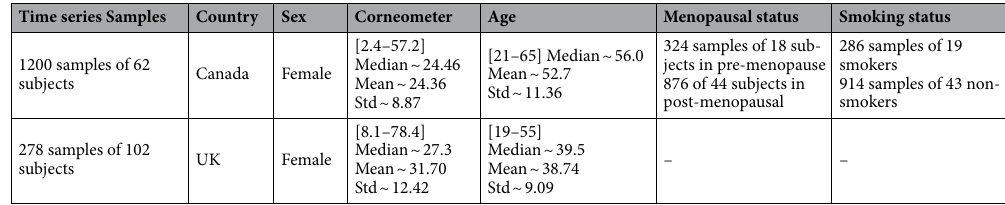
Table 1. Metadata for Canada and UK cohorts. See Supplementary Figure 1 for more details on the distributions of corneometer, age and samples per subjects. Also see Methods and Supplementary Notes for more detail on the sample